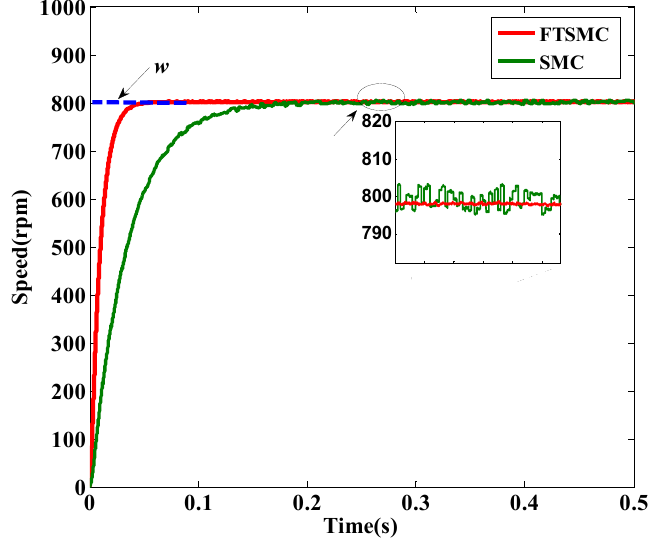
Figure 5. Starting speed curves.